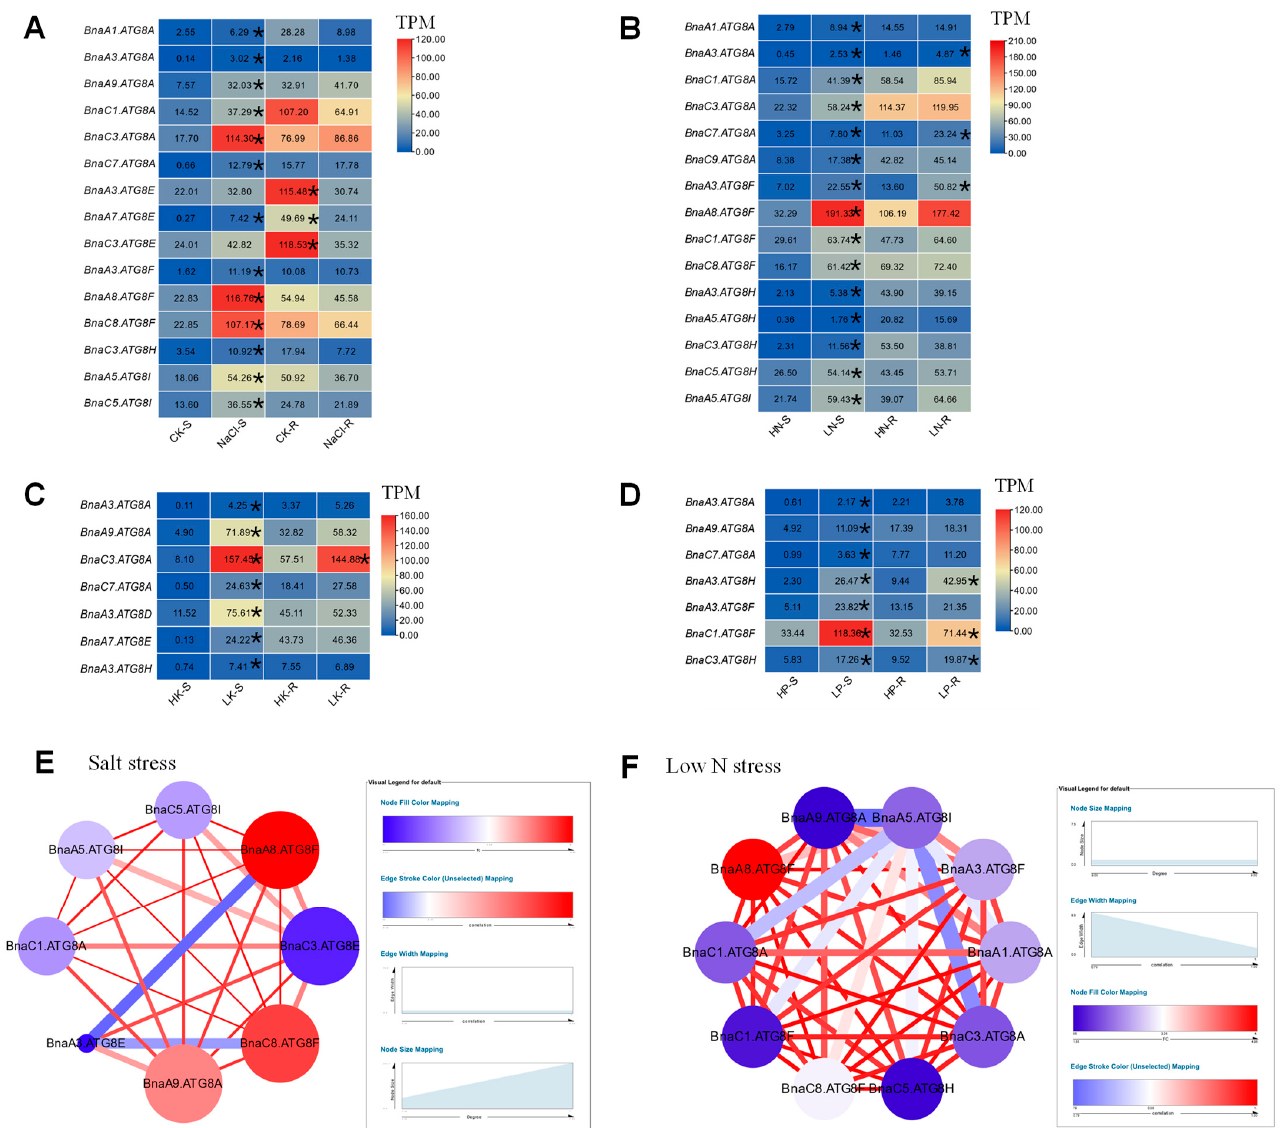
Figure 3. Transcriptional profiling of the differential expression of the ATG8s in B. napus under various nutrient stresses. ( A – D ) Differential expression profiling under salt stress ( A ), low nitrate stress ( B ), low potassium stress ( C ), and low phosphorus stress ( D ). ( E , F ) The gene co-expression network diagram involving ATG8s under salt and low nitrate stress. The shoots and roots were individually sampled, and each sample includes three independent biological replicates. The DEGs with the p -value <= 0.05 and |log 2 FC| > 1. Deleted genes with correlation values > 0.7 were used as the threshold for screening interactions between genes. The DEGs with higher expression are indicated with asterisks.